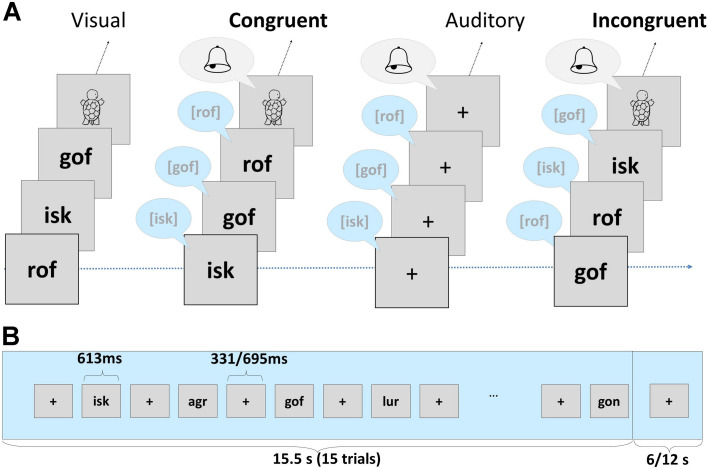
(A) Examples of nonwords presented in the experiment, including four conditions: unimodal visual, bimodal congruent (AVc), unimodal auditory and bimodal incongruent (AVi). Children had to press the response button whenever a visual, auditory or audiovisual target appeared (turtle, bell chime). (B) Illustration of the sequence and timing of one stimulation block. Each trial of the implicit audiovisual task began with the presentation of a fixation cross for 331 or 695 ms followed by a stimulus or target presentation for 613 ms. After 15 trials, a long fixation period of 6 or 12 s was presented (c.f. Karipidis et al., 2017, 2018; Pleisch et al., 2019a).